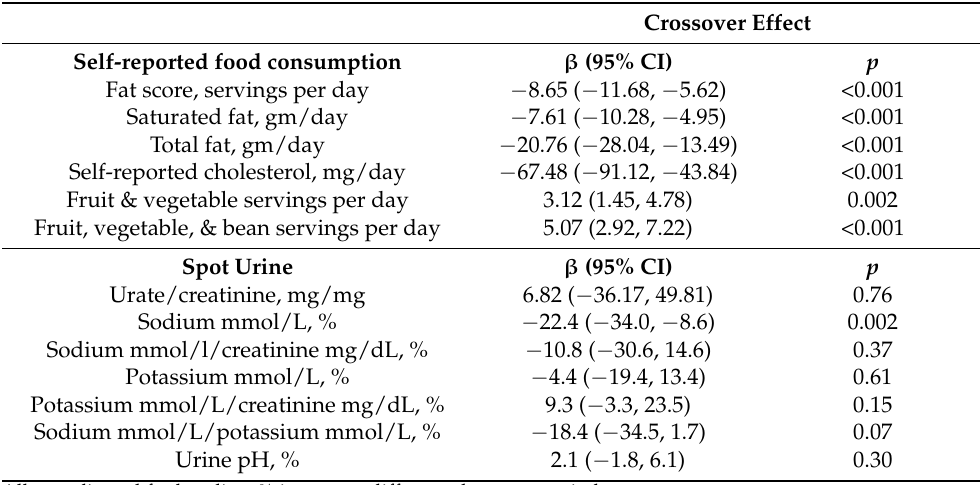
Effects of Dietitian Delivered DASH (DDG) versus Self-Directed (SD) Diet on Compliance